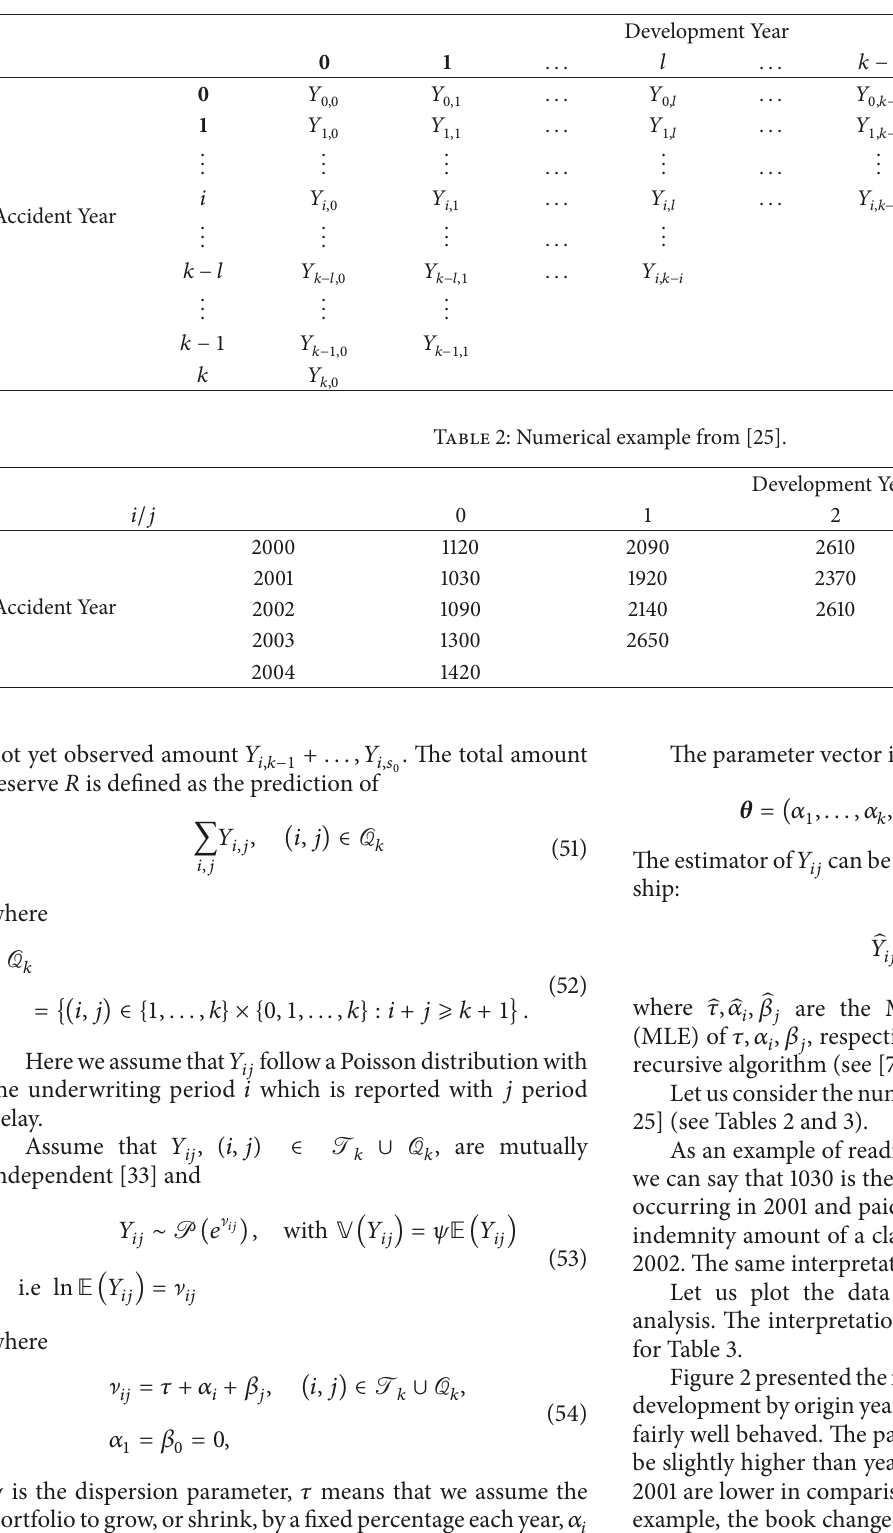
Table 1: Triangle of observed incremental payments.